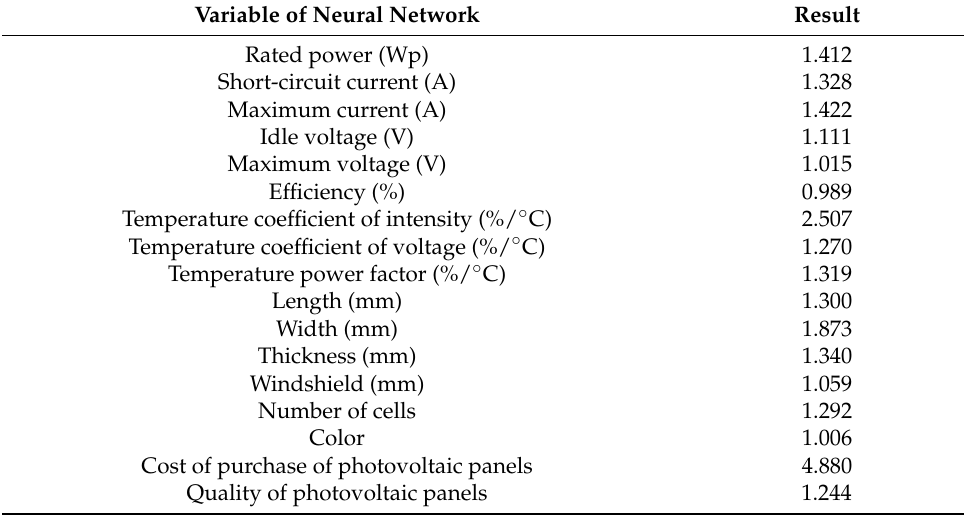
Table 14. Results of global sensitivity analysis from neural network MLP